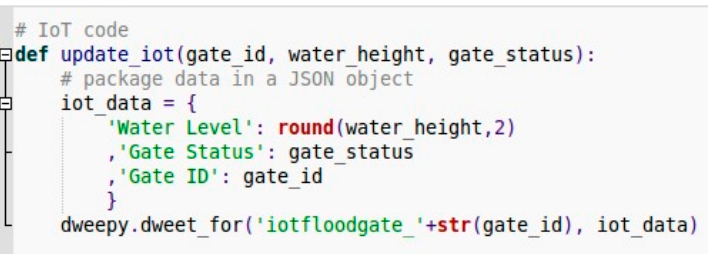
Figure 12. Code Excerpts: controlling motor to open the gate.